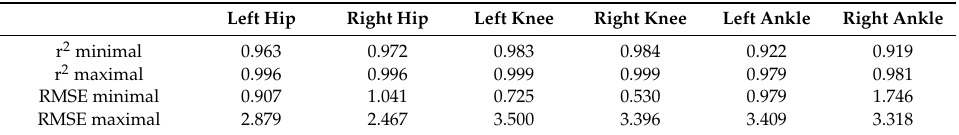
Table 3. Outcome subject-specific correlation analysis.